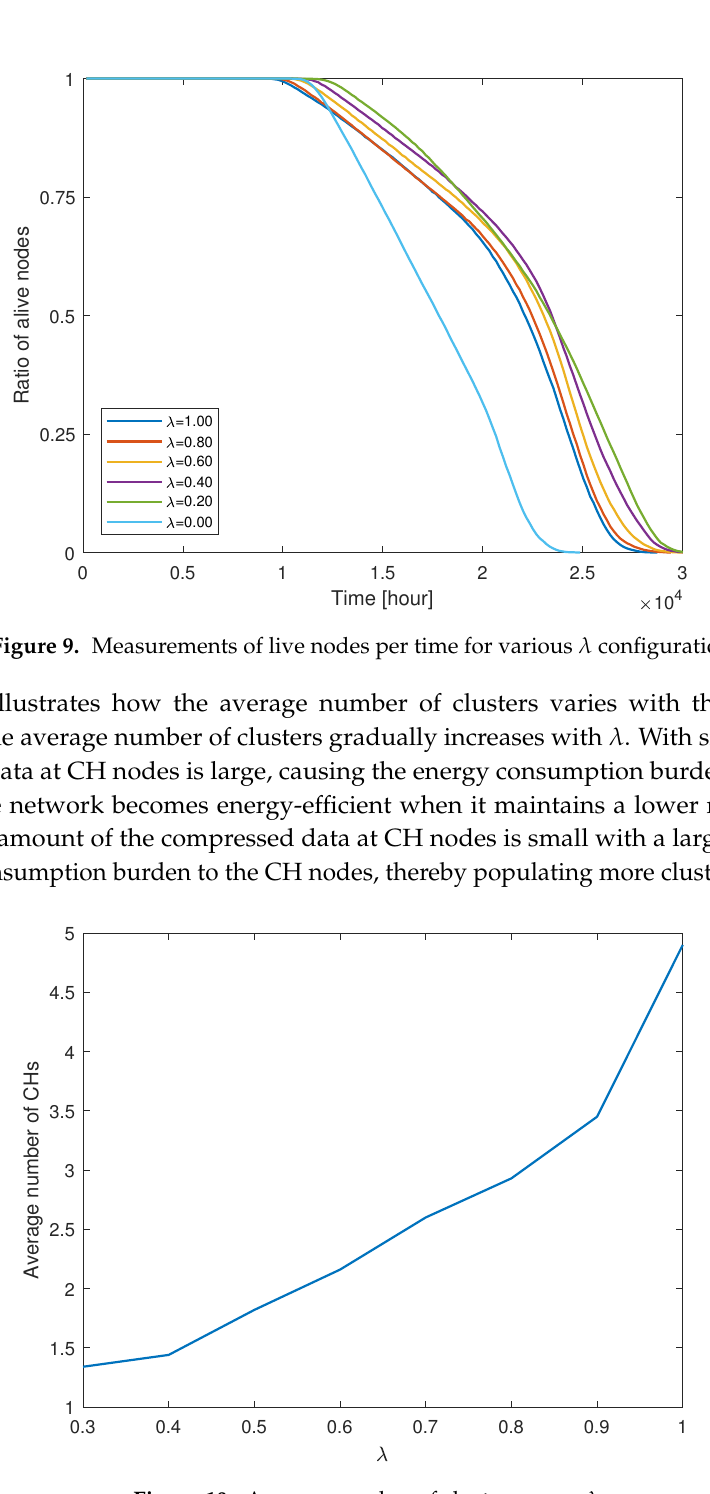
Figure 10. Average number of cluster versus λ